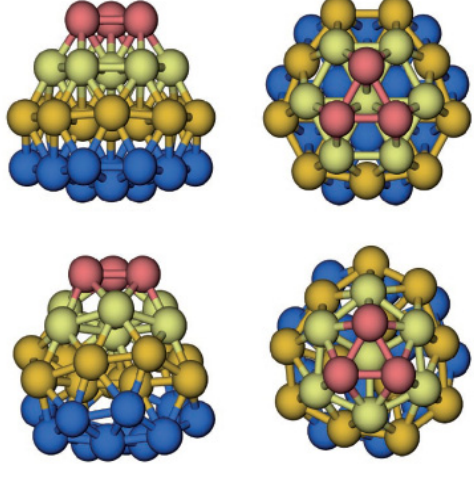
cluster with C 34